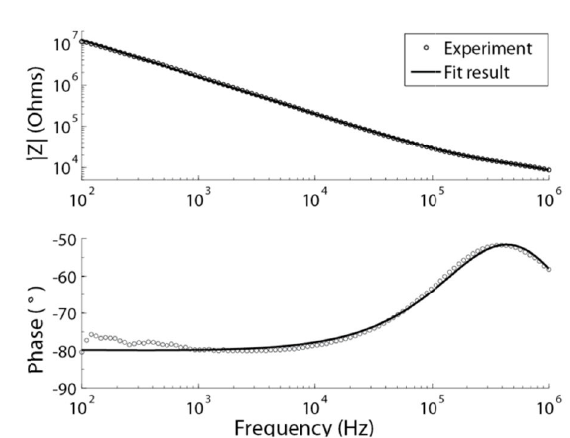
Fig. 6: Bode plot in Ringer’s solution and the corresponding fit